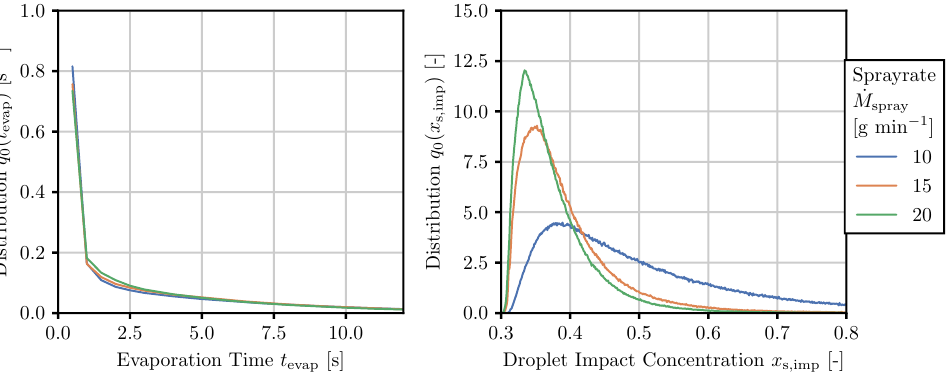
Figure 16. Influence of spray rate ˙ M spray on the tracked quantity distributions for the laboratory-scale case at ˙ V air = 105m 3 h − 1 , T air,in = 85°C, p spray = 1.8bar, T spray = 70°C unless otherwise